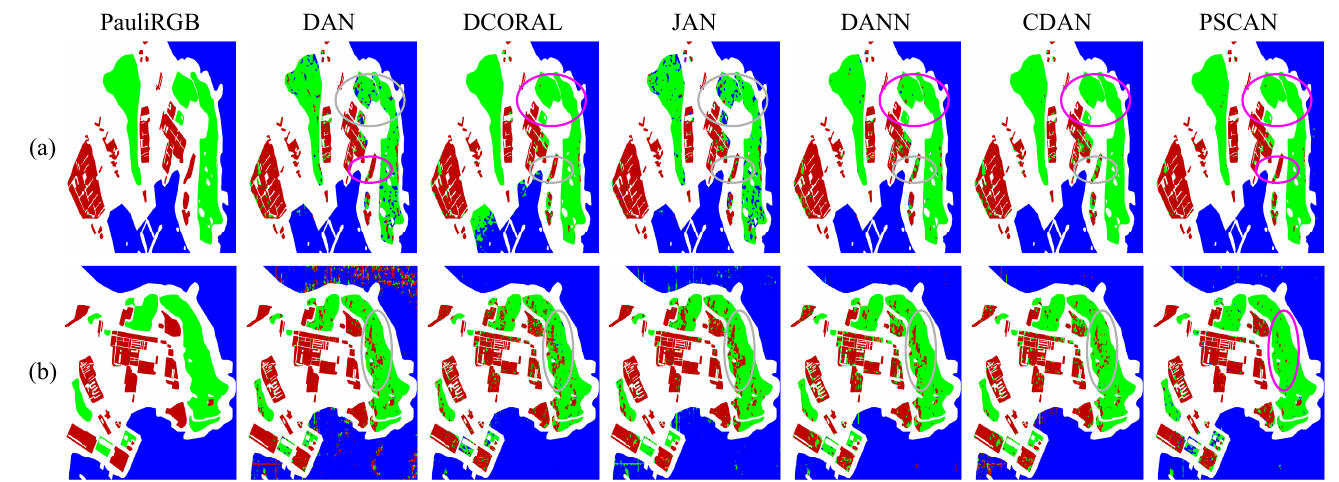
Figure 11. Comparison of the whole map classification results on the Qingdao area. The circles in pink and gray represent the correct and incorrect classification, respectively. ( a ) RS-2 as the target domain. ( b ) GF-3 as the target domain.